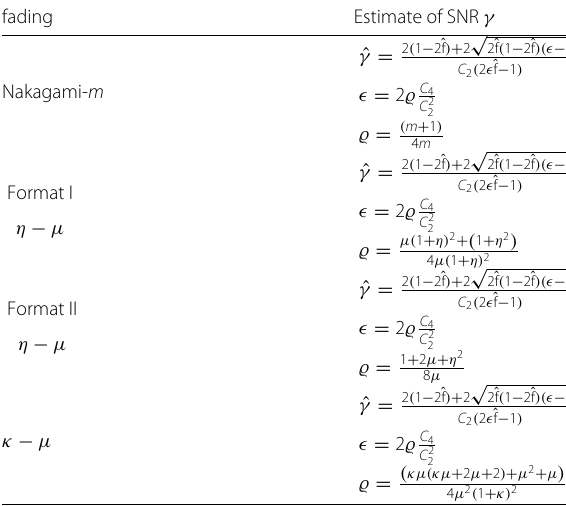
Table 1 SNR estimates under generalized fading fading Estimate of SNR γ